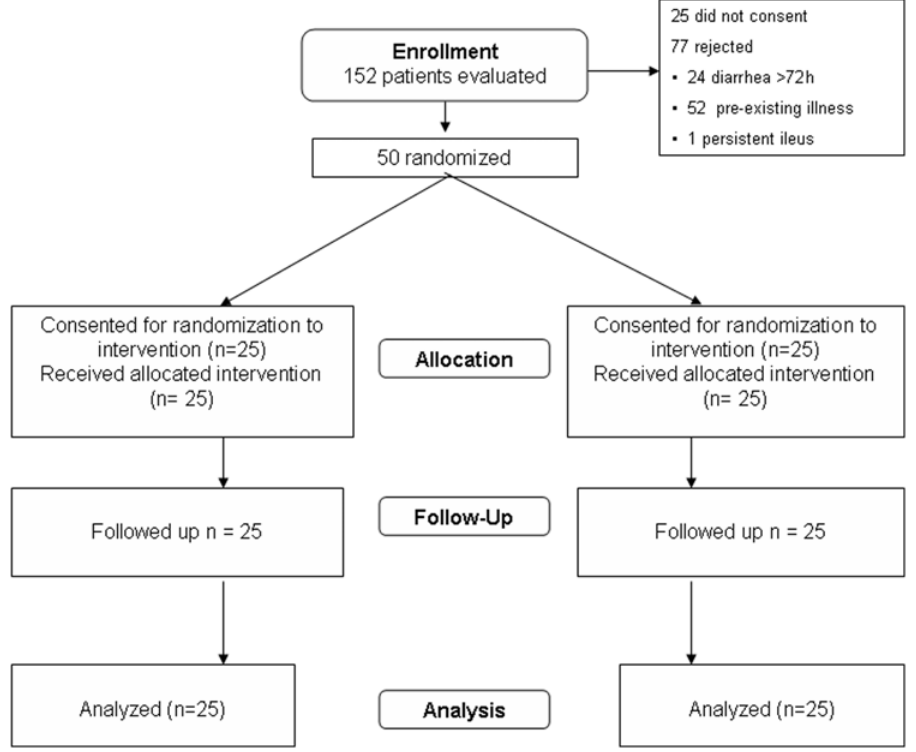
Figure 1. CONSORT flow diagram